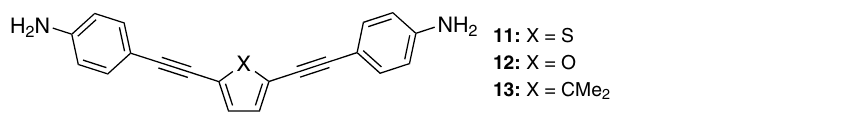
Figure 2. Molecules studied in ref. 24. Amine-terminated molecules 11–13 measured by